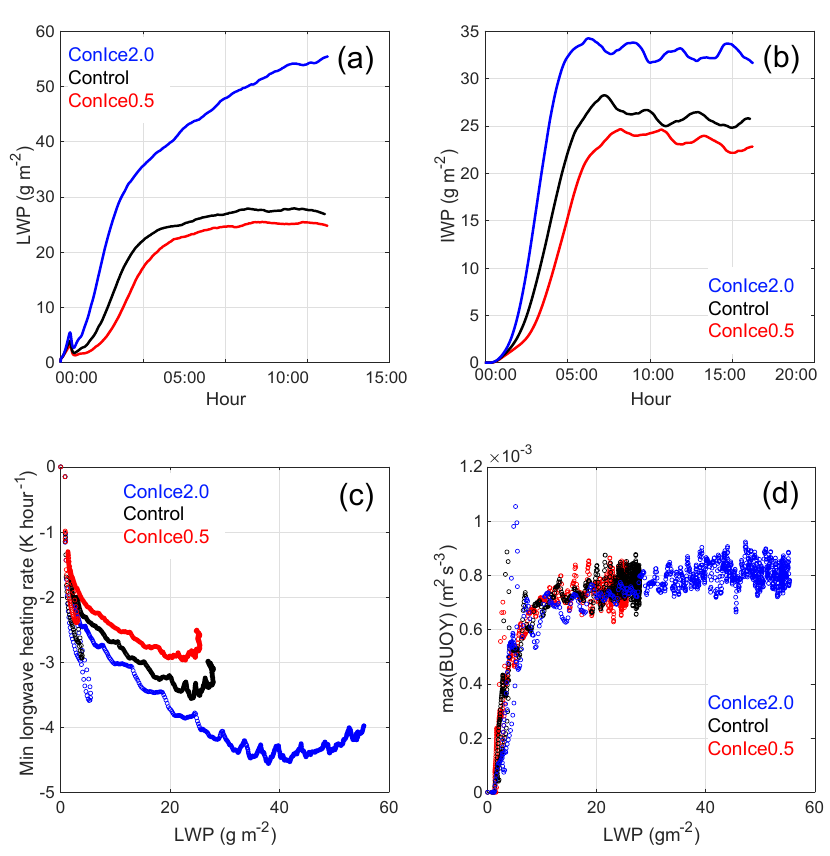
Figure 3. Time series from runs varying CCN concentrations with “constant” ice formation. (a) LWP, in units of gm − 2 . (b) IWP, in units of gm − 2 . (c) Scatterplot of minimum longwave heating rate vs. LWP, in units of Kh − 1 and gm − 2 , respectively. (d) Scatterplot of integrated buoyancy vs. LWP, in units of m 3 s − 3 and gm − 2 , respectively. For INP factors equal to 1.0 and CCN factors 2.0 (blue), 1.0 (black), and 0.5